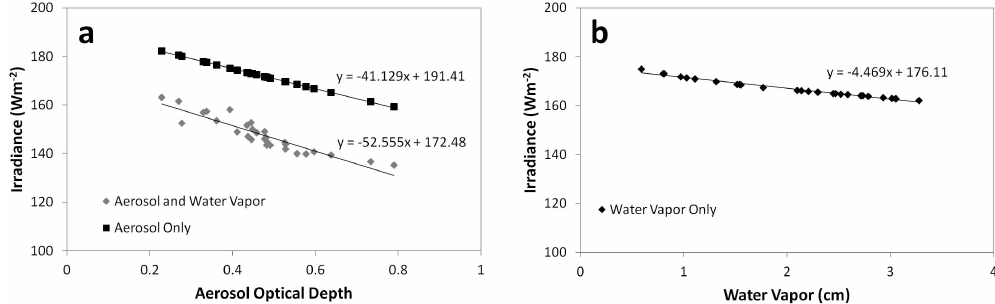
Fig. 12. Diurnally averaged forcing efficiency ( F e ) at Jaipur obtained from model calculations for (a) combined aerosol and water vapor (grey) and aerosol only (black); (b) water vapor only with no aerosol input.